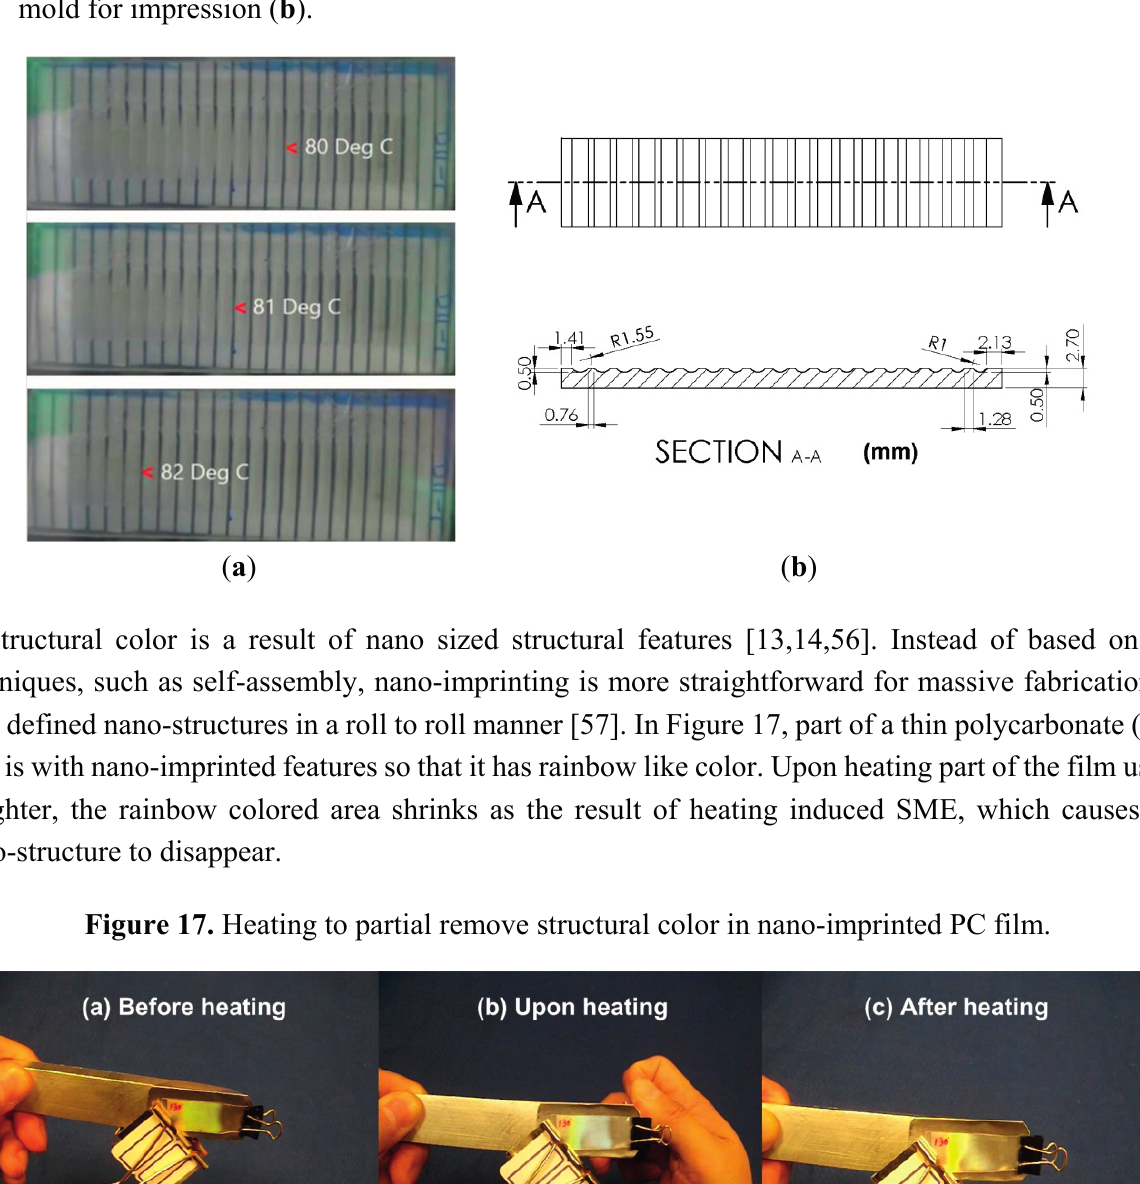
Figure 16. Polymeric temperature label upon heating ( a ) and cross-section of stainless steel mold for impression ( b ).